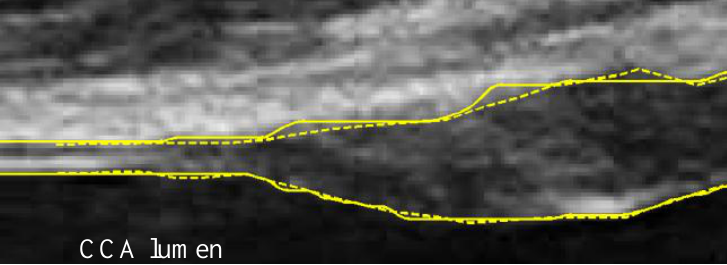
thickness. Solid line: automatic detection result. Dash line: Manual drawing. (Sequence S1).